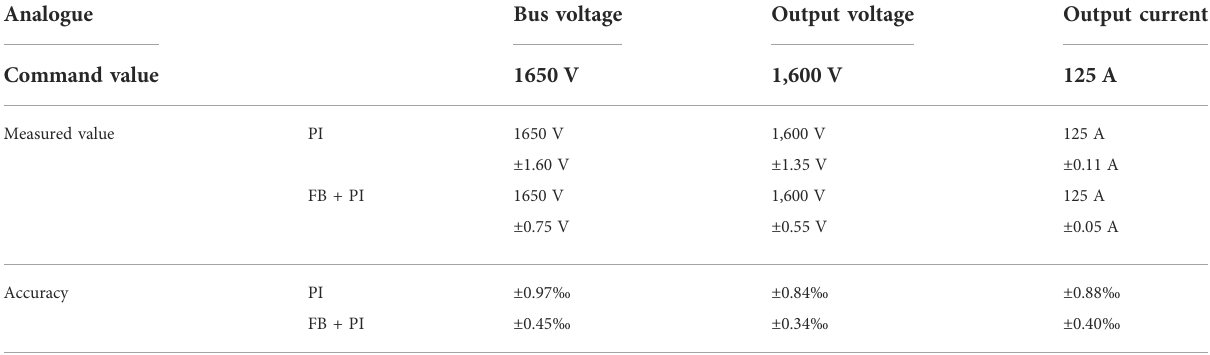
TABLE 4 Steady-state control accuracy of each parameter under grid imbalance conditions.